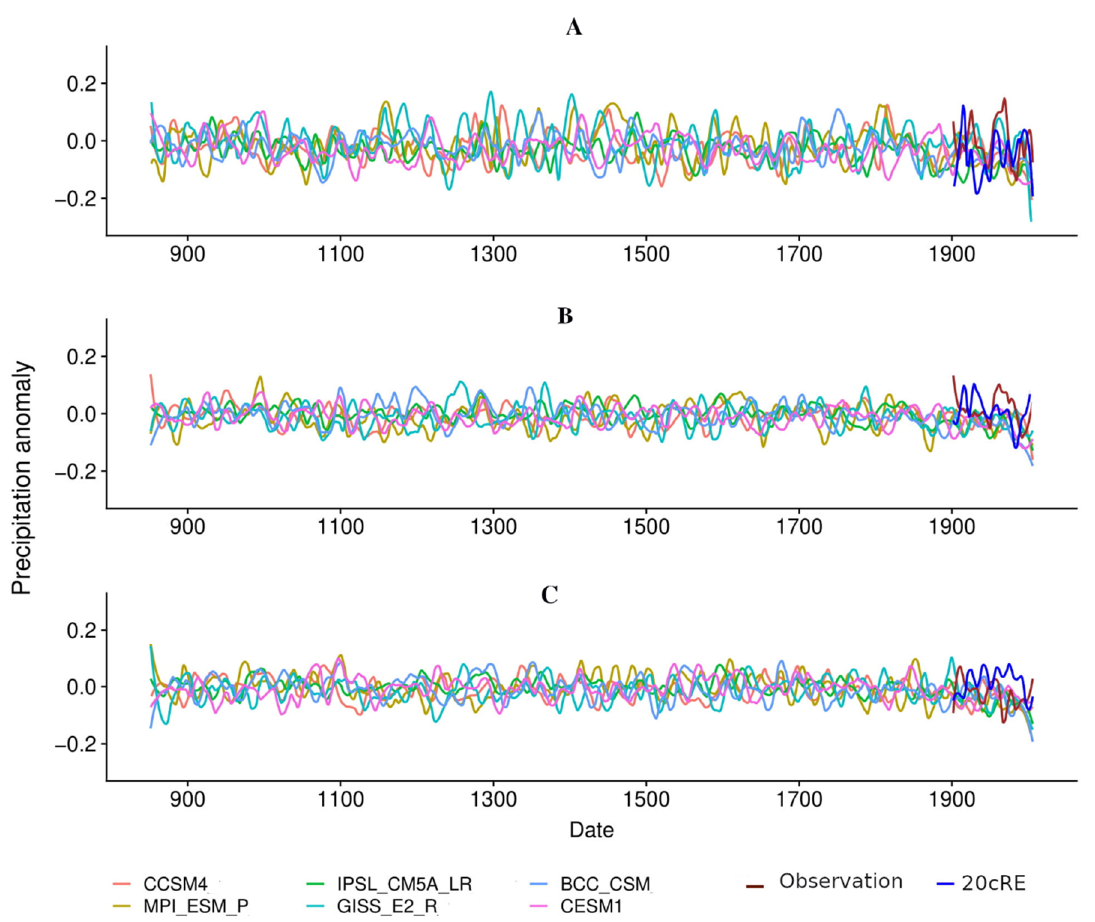
Figure 8. Loess-smoothed (30-year window) time series of monthly area averaged precipitation data for ( A ) western, ( B ) central, and ( C ) eastern parts of North Africa over the past millennium for PMIP3/CMIP5 model simulations and over the 20th century for observations and reanalysis.